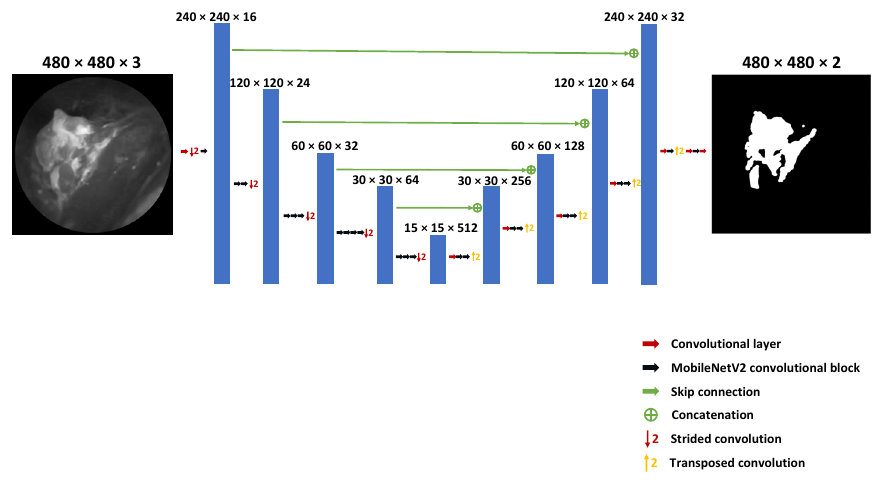
Figure 3. UNet architecture with MobileNetV2 backbone for fluorescence target segmentation.